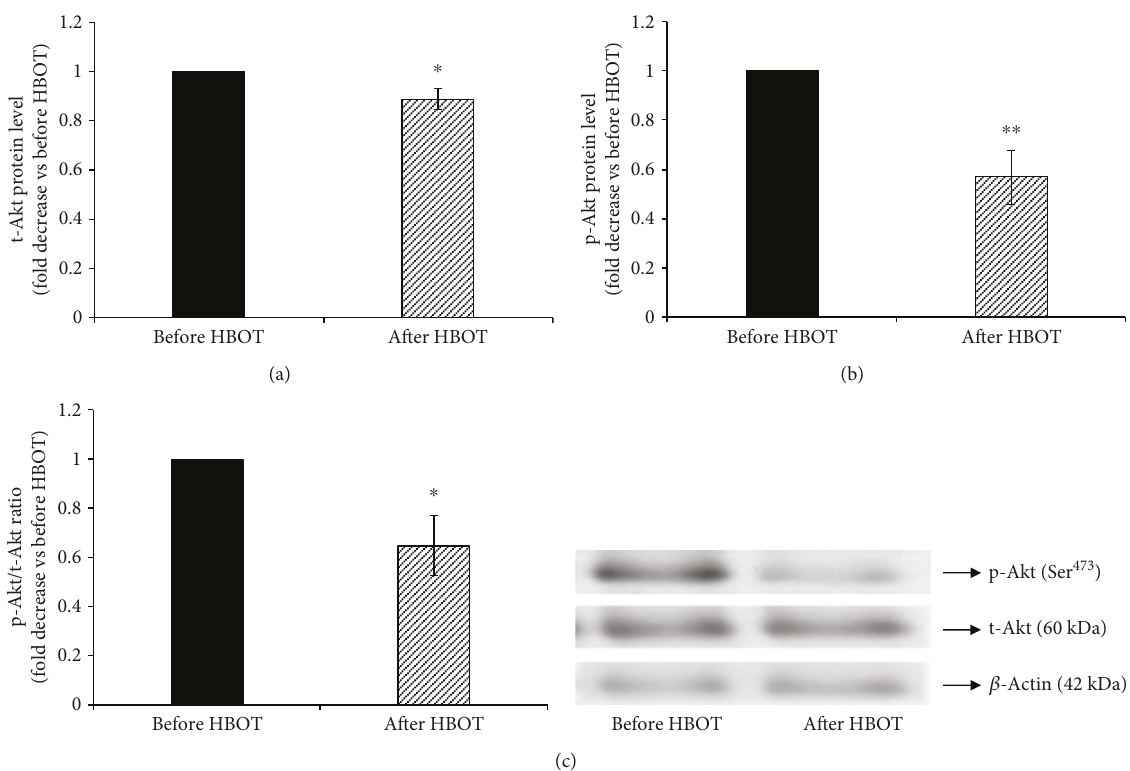
Figure 5: Phosphorylation of Akt at Ser 473 in lymphocytes after HBO exposure. (a) Level of t-Akt protein in lymphocytes, normalized to β -actin and expressed as fold change before HBOT (arbitrary control set at 1); (b) level of p-Akt (Ser 473 ) protein in lymphocytes, expressed as fold change before HBOT (arbitrary control set at 1); (c) ratio of p-Akt/t-Akt expressed as fold change before HBOT (arbitrary control set at 1). Inset: representative Western blots ( n = 7 ); ∗∗ p < 0 01 ; ∗ p < 0 05 ; p-Akt: the phosphorylated form of protein kinase B; t-Akt: the total form of protein kinase B. Other abbreviations are under Table